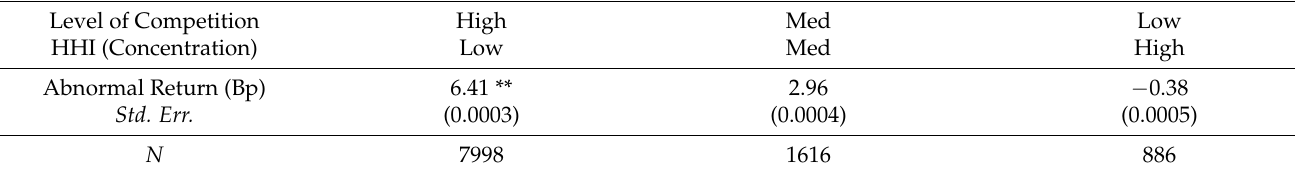
Table 4. Univariate